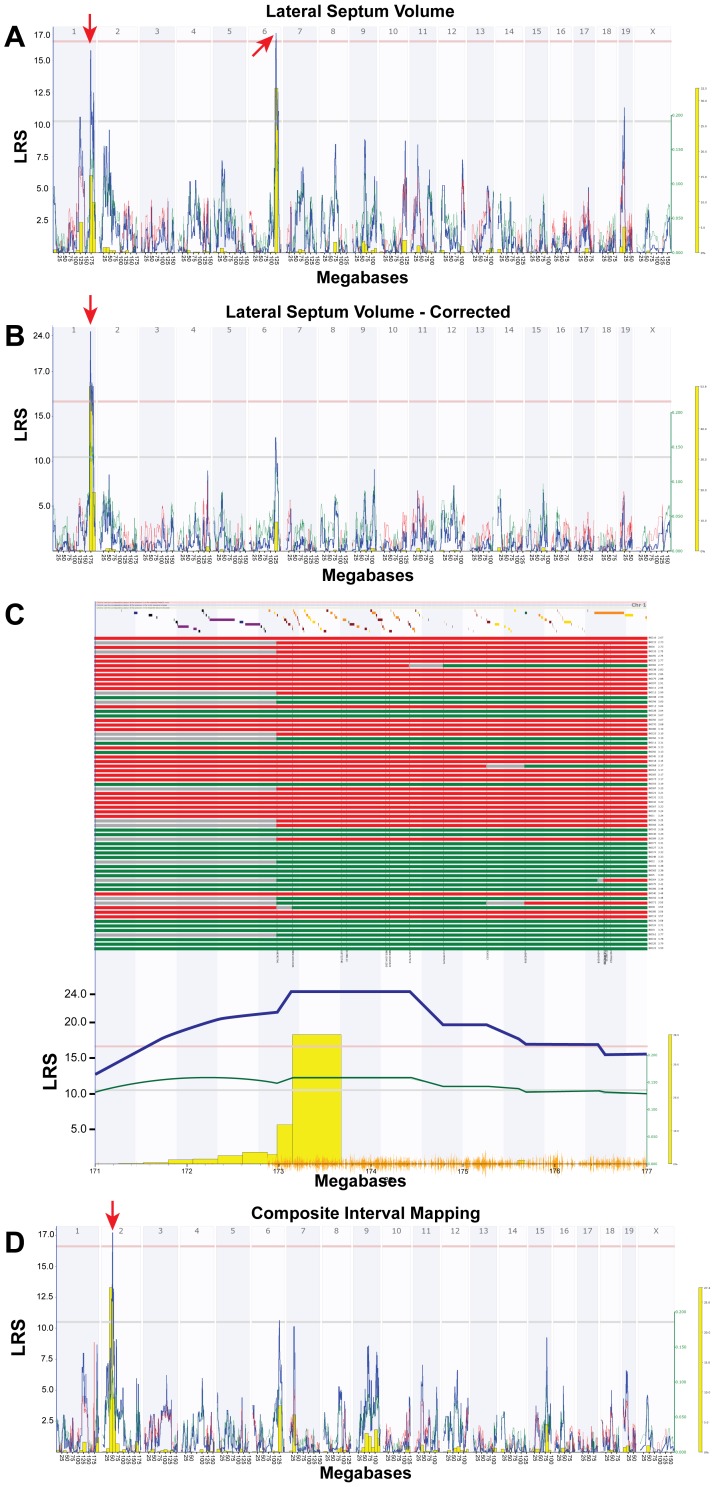
Mapping LS volume in BXD RI strains. A. Interval map of LS corrected for histological shrinkage across the entire genome. The x-axis represents the physical map of the genome; the y-axis and thick blue line provide the LRS of the association between the trait and the genotypes of markers. The two horizontal lines are the suggestive (blue) and significance (red) thresholds computed using 1000 permutations. There is a significant QTL mapping to the distal portion of Chr. 6 and a suggestive QTL mapping to the distal portion of Chr 1 (red arrow). B. Interval map of LS volume corrected for shrinkage with the effects of age, sex, epoch, and brain weight regressed out. The Chr 1 QTL seen in panel A is now significant (red arrow). C. Haplotype map of all 69 BXD strains on 6 Mb QTL interval on Chr1 (171–176 Mb). Red lines indicate C57BL/6J alleles (maternal), green lines indicate DBA/2J alleles (paternal), and gray lines are unknown. Strains are arranged from smallest to largest LS volume (top to bottom). D. Composite interval mapping indicates a QTL on the proximal portion of Chr 2 (45–55 Mb).